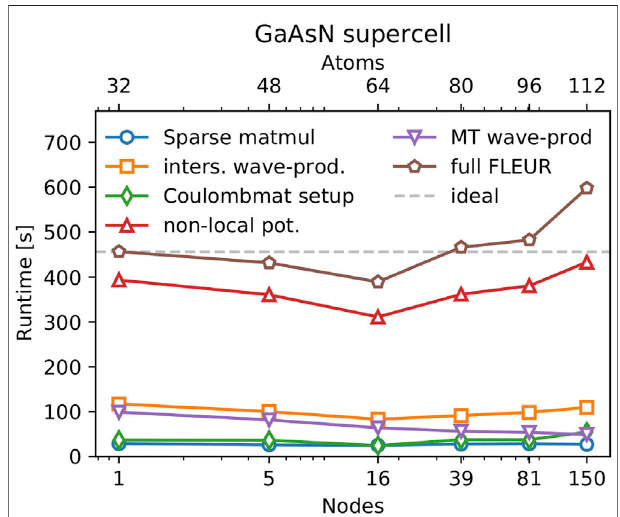
FIGURE 5 | Weak scaling behavior of FLEUR ’ s hybrid functional calculations for a GaAs system which is scaled into a supercell with one Arsenic atom being substituted with Nitrogen. The y -axis shows the runtime for different code parts, while the bottom x -axis shows the number of nodes used. The top x -axis shows the number of atoms in that particular